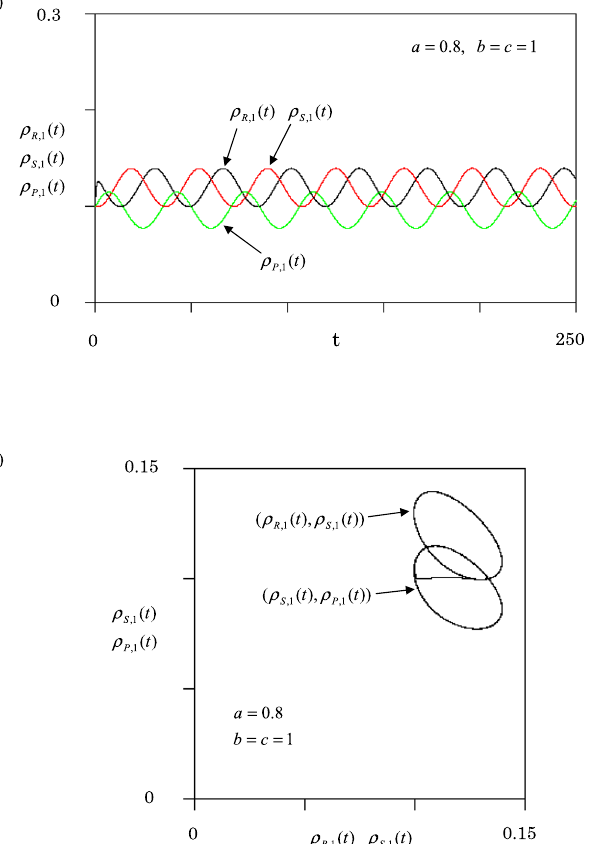
Figure 5. Population dynamics at rate = . a 0 8 and = = b c 1 for homogeneous graph. ( a ) Three densities in node 1 are plotted against time t . ( b ) Two orbits ( ρ t ( )